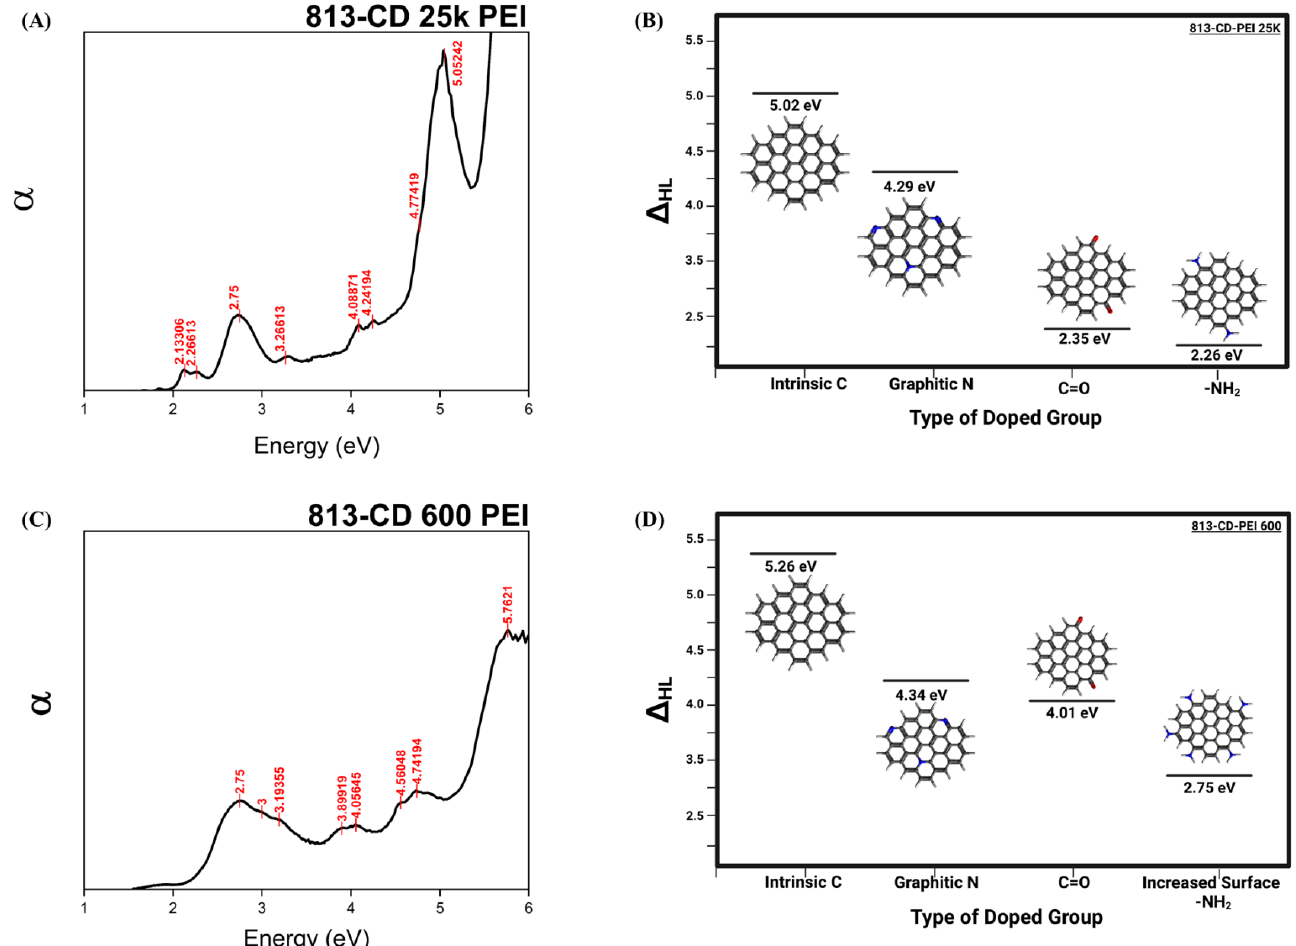
Figure 3. α vs energy plot of ( A ) 813-CD 25k PEI. ( B ) model representation of ∆ HL versus type of doped group of 813-CD 25k PEI. ( C ) α vs energy plot of 813-CD 600 PEI. ( D ) Model representation of model representation of ∆ HL versus type of doped group of 813-CD 600 PEI. Created with BioRender.com, accessed on 1 January 2023.